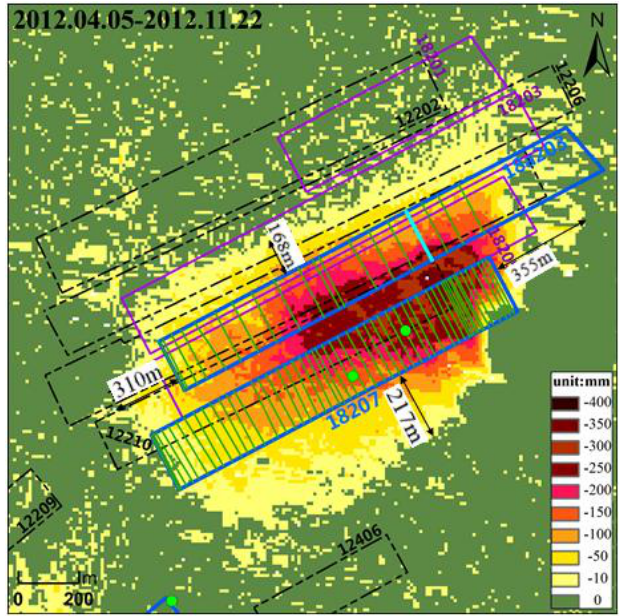
Figure 11. Final SHB caused by 18207 working face during the observation